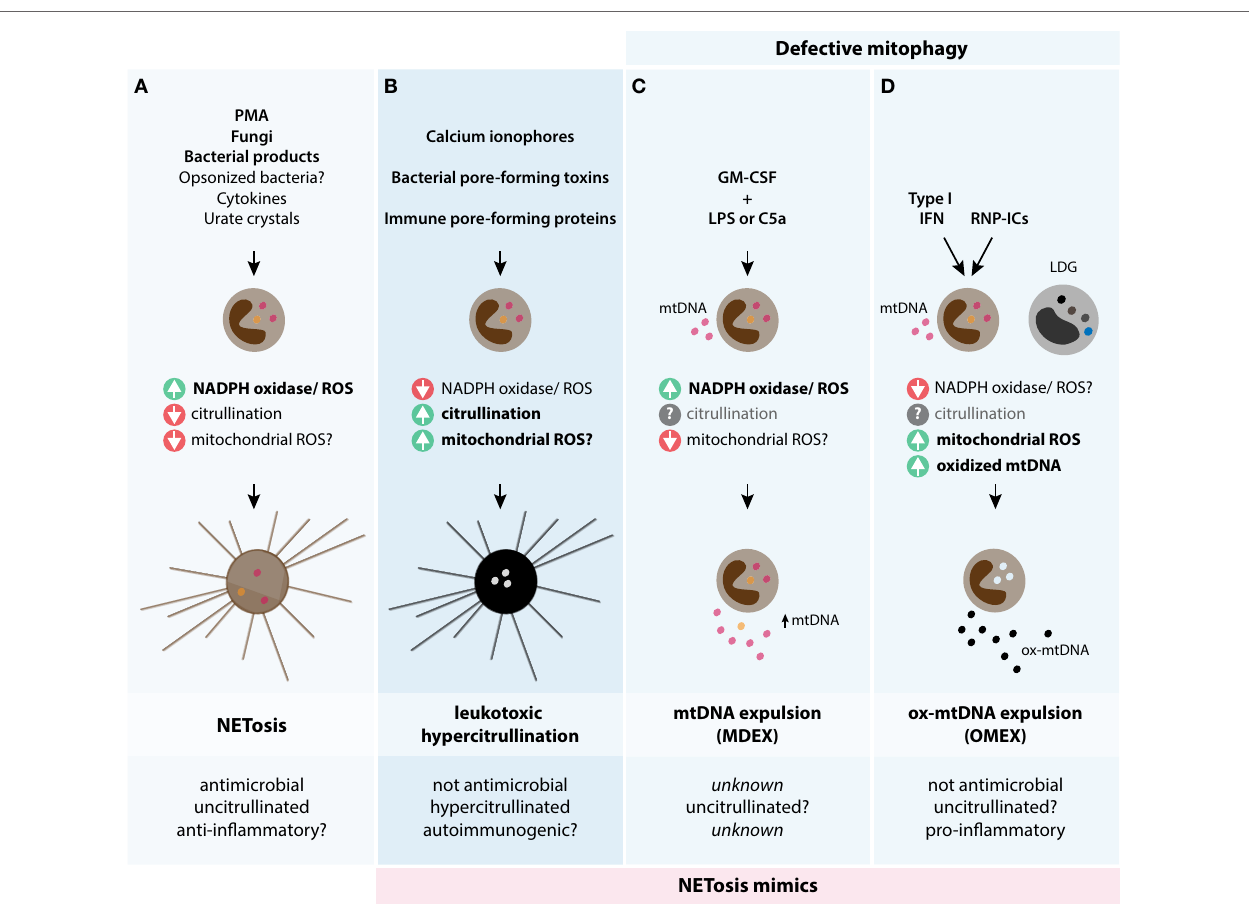
FigUre 4 | theoretical models of biological mechanisms of dna release in neutrophils . The three models are depicted and illustrate their potential triggers, biochemical pathways, and biological consequences. (a) NETosis is initiated by stimuli that potently activate NADPH oxidase and ROS production, but decreases PAD4 activation and likely mtROS production. NETosis is antimicrobial, potentially anti-inflammatory, and has limited protein citrullination. (B) Leukotoxic hypercitrullination is triggered by stimuli that generate prominent and sustained increases in cytosolic calcium, such as ionophores and proteins that damage the cellular membrane (e.g., pore-forming proteins). PAD hyperactivation and protein hypercitrullination are characteristic of this process, but not ROS production by NADPH oxidase. While mtROS may have some role in the release of DNA by calcium ionophores in neutrophils (32), the relevance of this pathway in neutrophil damage induced by pore-forming proteins is unknown. Antimicrobial functions and the immunogenicity of self-antigens are affected as a result of cellular hypercitrullination. (C,d) To compensate a constitutive defect in mitophagy, neutrophils normally extrude mitochondrial components, including mtDNA, as a mechanism for mitochondria clearance. (C) The process of mtDNA expulsion (MDEX) may be enhanced by inflammatory signals such LPS or C5a following neutrophil priming with GM-CSF and requires NADPH oxidase activity. (d) IFN-I and RNP-ICs alter the normal disposal of mitochondria in neutrophils and promote the expulsion of ox-mtDNA (OMEX). This process is dependent on mtROS, but not NADPH oxidase, and may be predisposed by factors that decrease NADPH oxidase activity. Different to mtDNA, ox-mtDNA is pro-inflammatory and highly interferogenic. LDGs from patients with SLE have spontaneous OMEX. The role of citrullination in (C,d) is unknown. The question marks (?) reflect pathways/functions that require further experimental